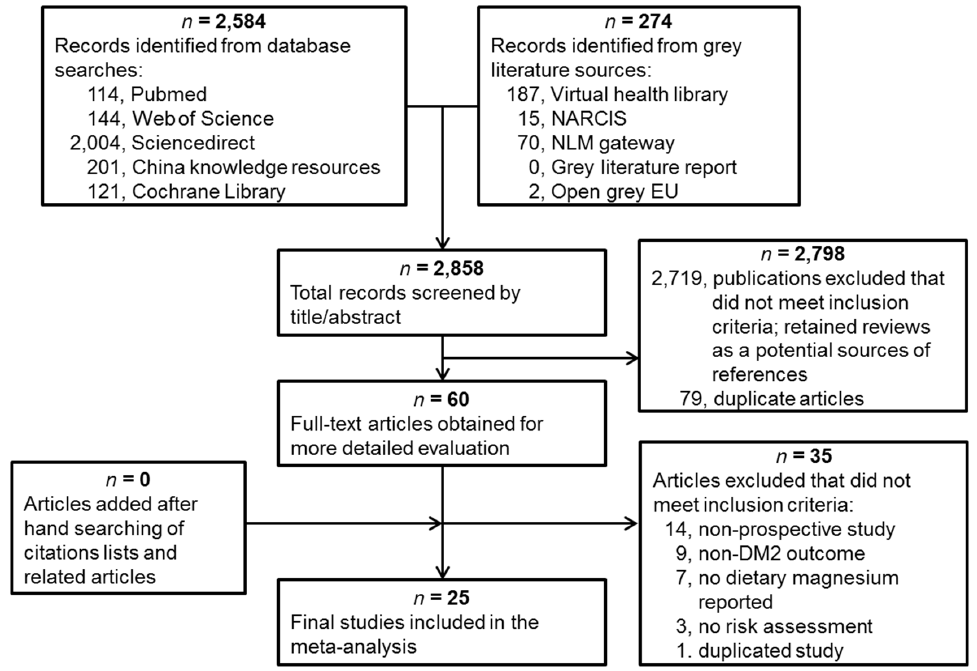
Figure 1. Screening and selection of articles on dietary magnesium intake and risk of type 2 diabetes mellitus.